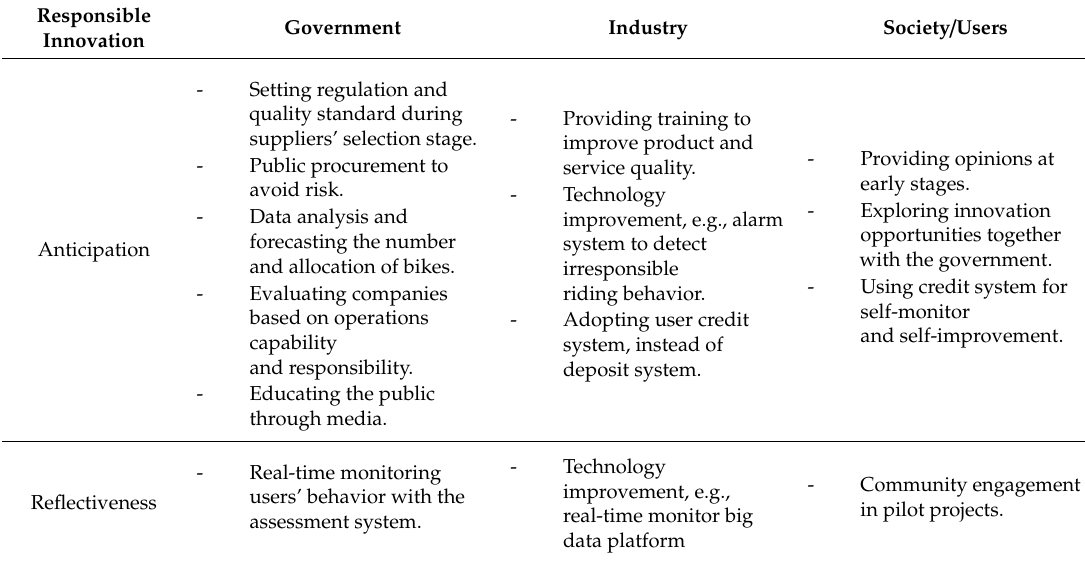
Table 3. Collaborative governance for responsible